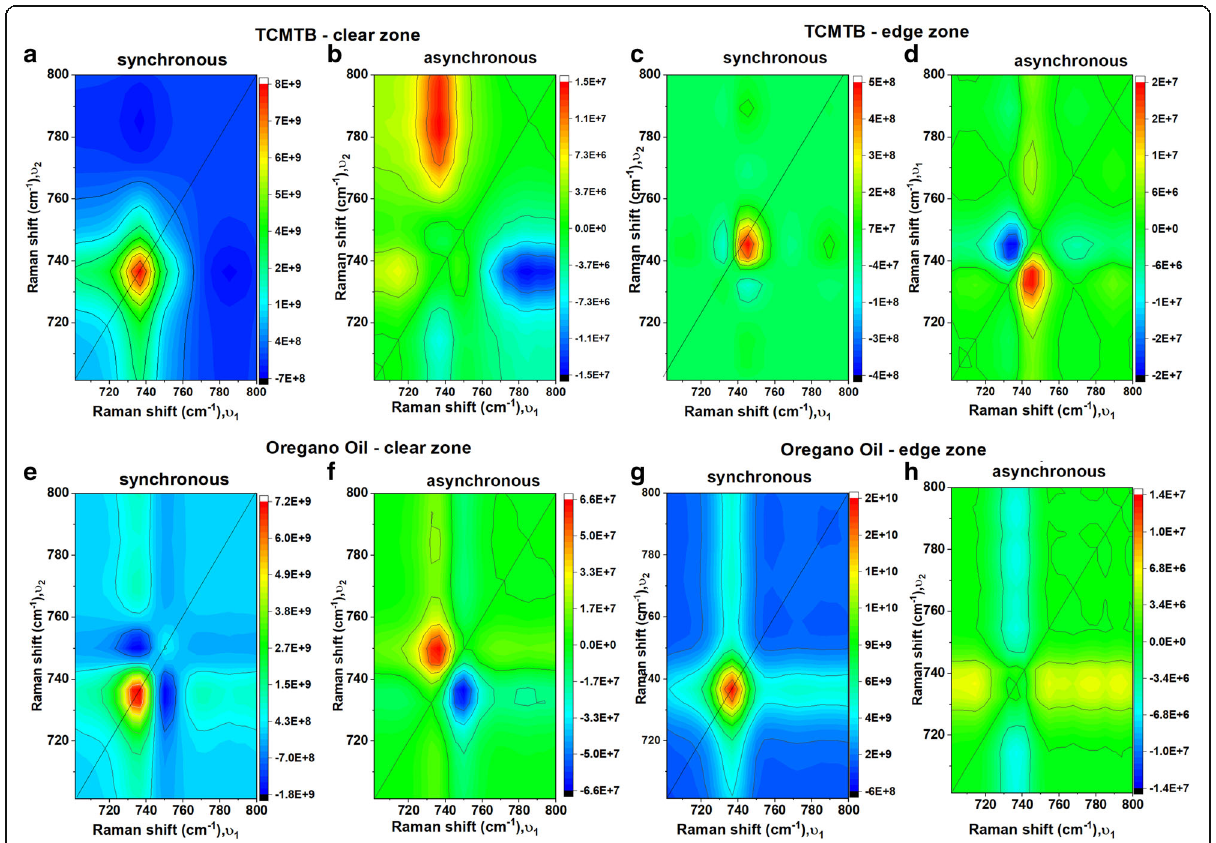
Fig. 8 Expanded view of 2D correlation map from Figs. 6, 7 with Raman shift range 700 – 800 cm − 1 . (TCMTB clear and outer edge zone synchronous ( a , c ) and asynchronous ( b , d ) and oregano oil clear and outer edge zone synchronous ( e , g ) and asynchronous ( f , h